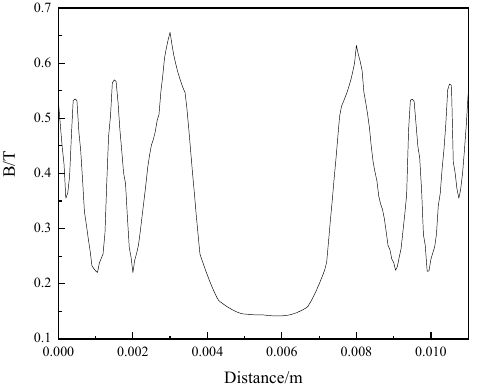
Figure 11. The distribution of the magnetic flux density in the sealing gap.